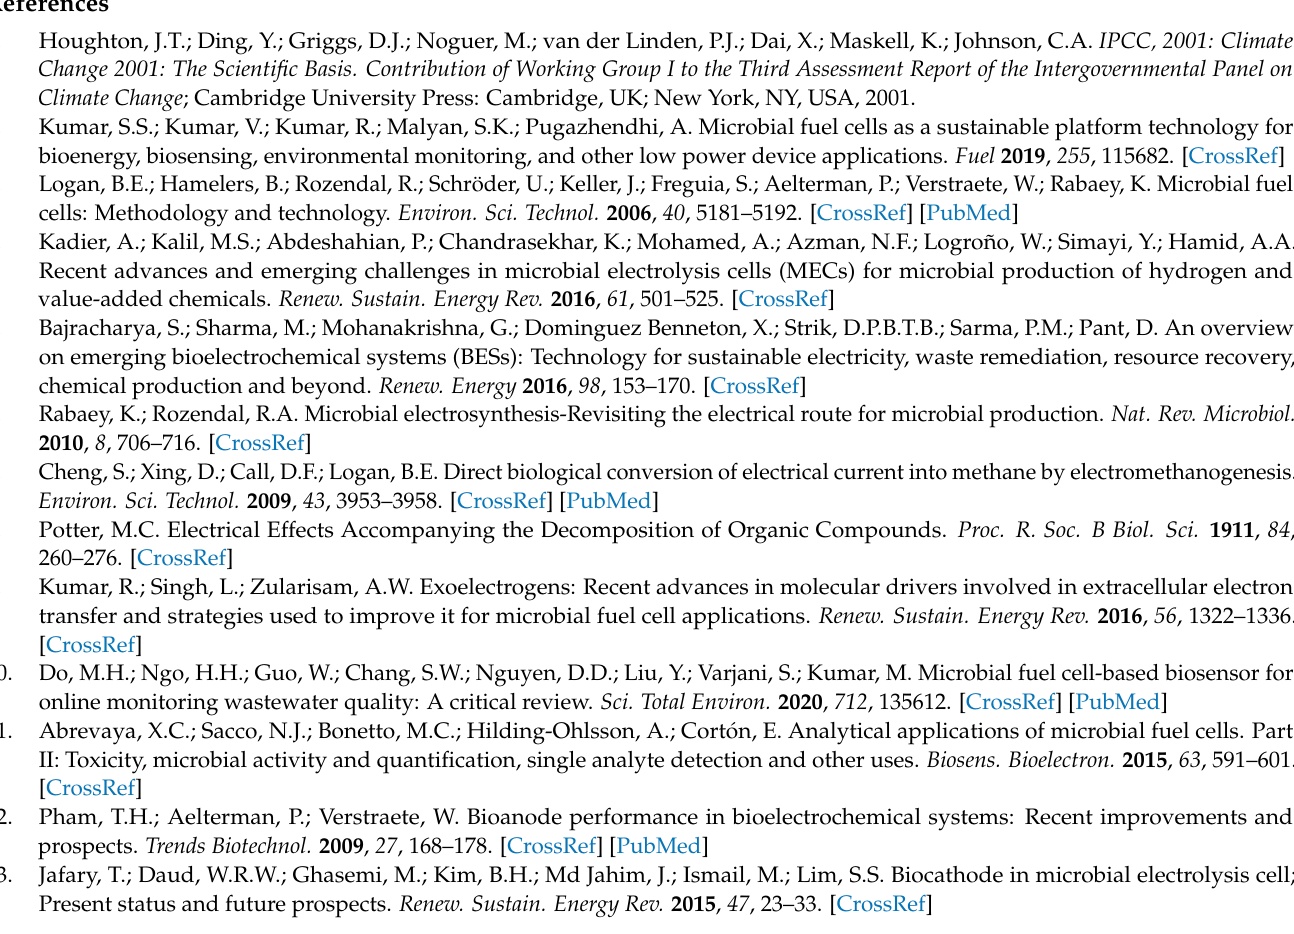
analysis; Table S2: Amplicon sequence variants table of all bacteria detected; Table S3: Supplementary data to Figure 2; Table S4: Supplementary data to Figure